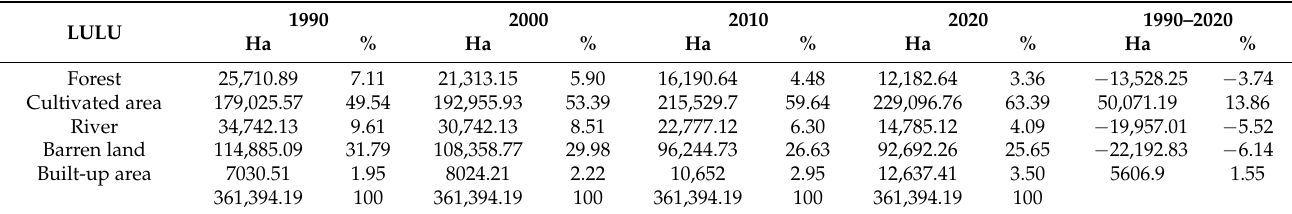
Table 4. Summary of LULC changes from 1990 to 2020.